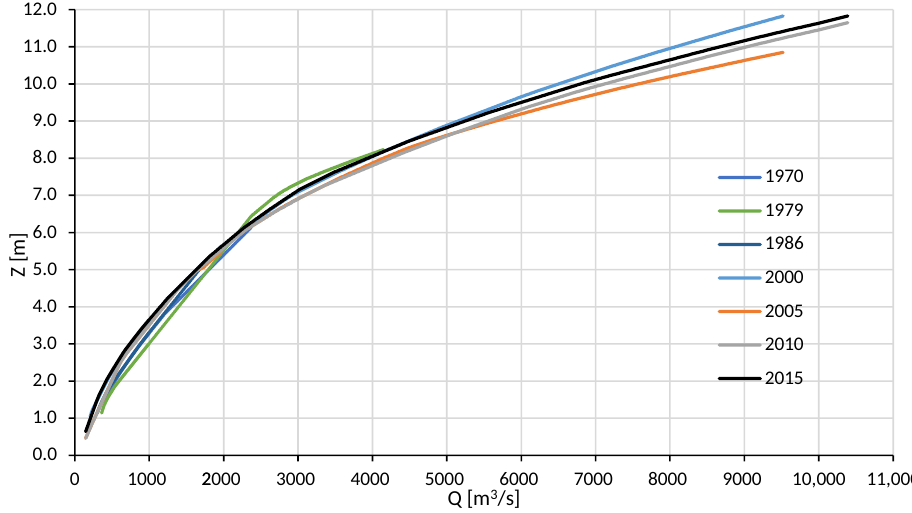
Figure 4. Rating curves for the Tczew river gauge (909.140 km), years 1970–2015. The upper boundary condition for the simulations was the hypothetical flow hydro- graph downstream the Włocławek Dam. It was prepared on the basis of daily observations of the flow in the Włocławek Dam cross section in the period from 2006 to 2016 with the hypothetical flood peak Q 0.2% = 9885 m 3 /s (from 10 June to 16 July 2007), Q 1% = 8008 m 3 /s (from 14 September to 6 November 2008) and Q 10% = 5195 m 3 /s (from 3 March to 8 April 2010) shown in Figure 5. For the 39-year simulation period, the 10-year hypothetical hydrograph was repeated four times. The simulation time starts in 2016.